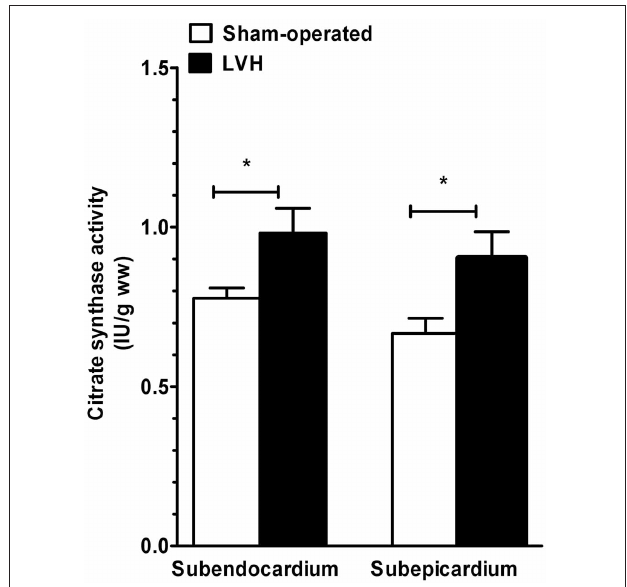
FIGURE 4 | Subendocardium and subepicardium citrate synthase activity in sham-operated and LVH groups. Citrate synthase activity is used to approach global mitochondrial content in tissues and is expressed as units of activity per gram of tissue wet weight (IU.g